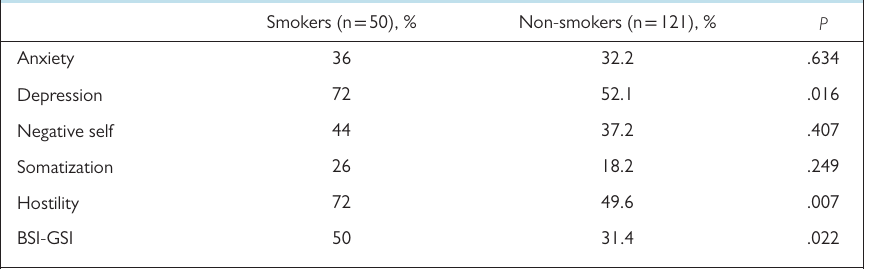
Table 2. The Rate of BSI Scores at Psychopathological Levels in Smoking and Non-smoking